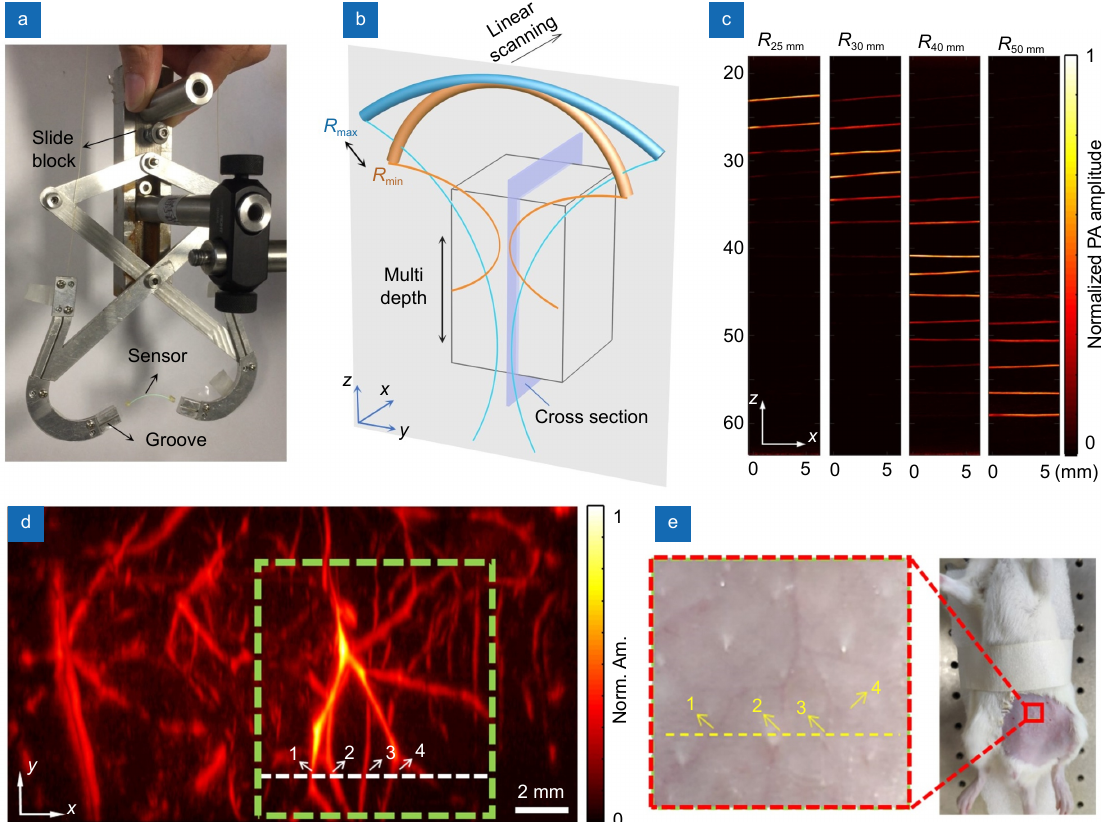
Fig. 8 | ( a ) Photograph of the holder for adjusting the bending curvature of the sensor. ( b ) Schematic of the multidepth PACT. ( c ) Photoacoustic images of human hairs at different depths in the x - z plane. ( d ) In vivo photoacoustic image of the abdominal subcutaneous vasculature of a rat. ( e ) Photograph of the rat with the fur removed before imaging. The red dashed box in (e) corresponds to the green box in (d). The yellow dashed line in (e) corresponds to the white dashed line in (d). Figure reproduced with permission from ref. 36 , AIP